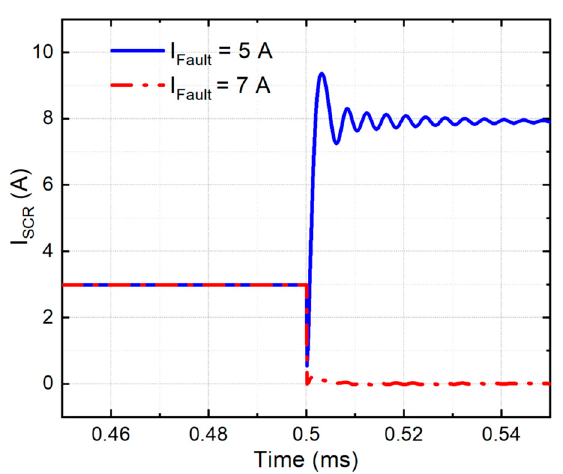
Figure 2. Silicon controlled rectifier (SCR) currents of ZCB in two different cases of fault current, to prove the feasibility of the ZCB control.